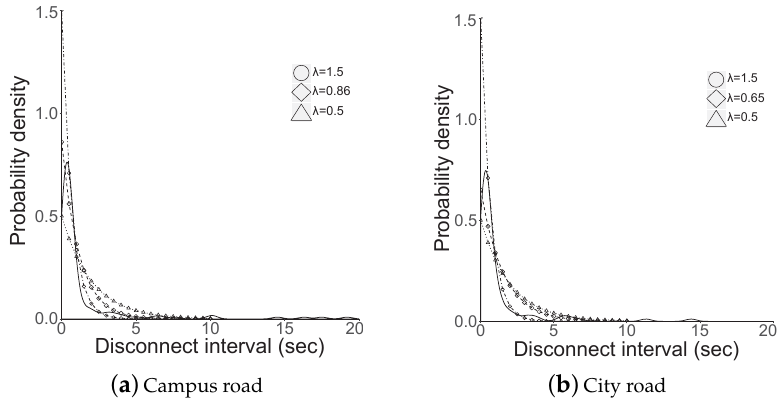
Figure 12. Probability density of